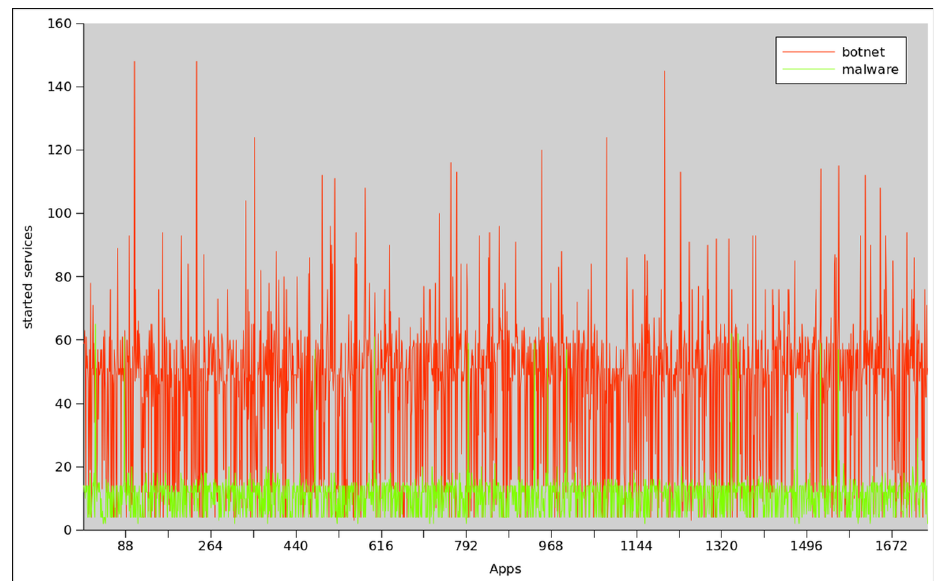
Fig 26. Started Services frequency analysis between botnet and malware applications.